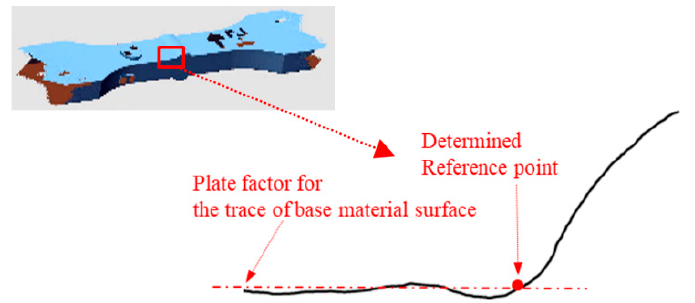
Figure 13. Changeable profile and the determination of the reference point.